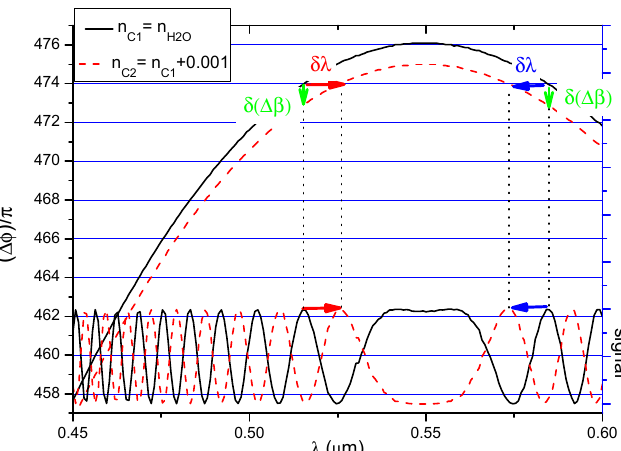
Figure 7. Left vertical axis: phase difference Δ ϕ between the modes divided by π for n H2O ( λ ) (solid line) and n c2 ( λ ) (broken line). Right vertical axis: light intensity distribution for both covers after light propagates 12 mm.